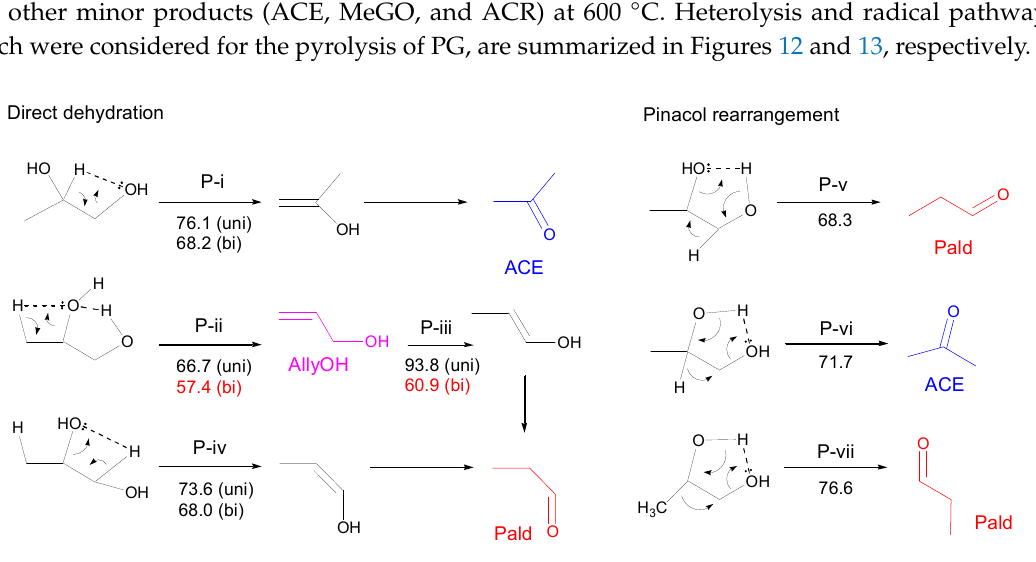
Figure 13. Possible radical chain pathways from the C- and O-centered radicals of propylene glycol (PG). The bond with a bold line, which is located at the β -position to the radical, is expected to be cleaved through a β -scission reaction. Pald, propionaldehyde; AllyOH, allyl alcohol; MeGO,